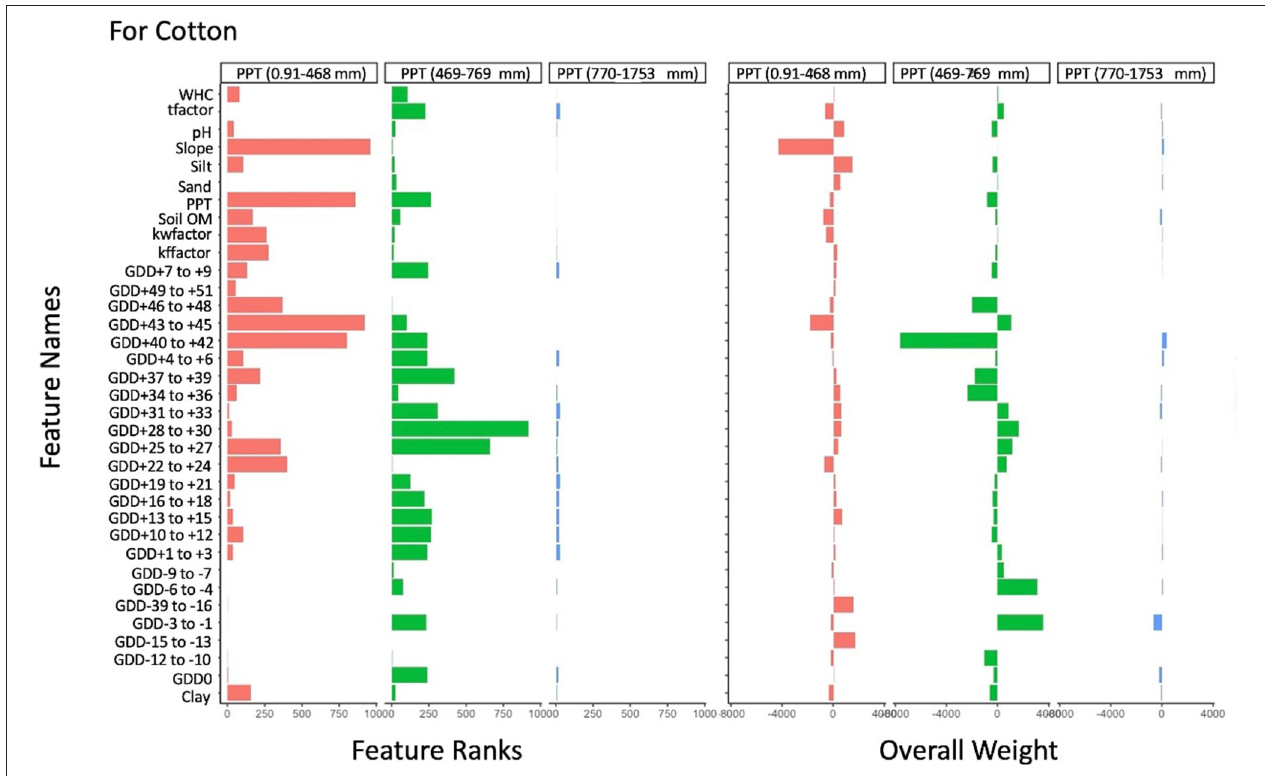
FIGURE 8 | Feature ranks and overall weight of features following explainable machine learning interpretations for cotton for low, medium, and high quartiles of